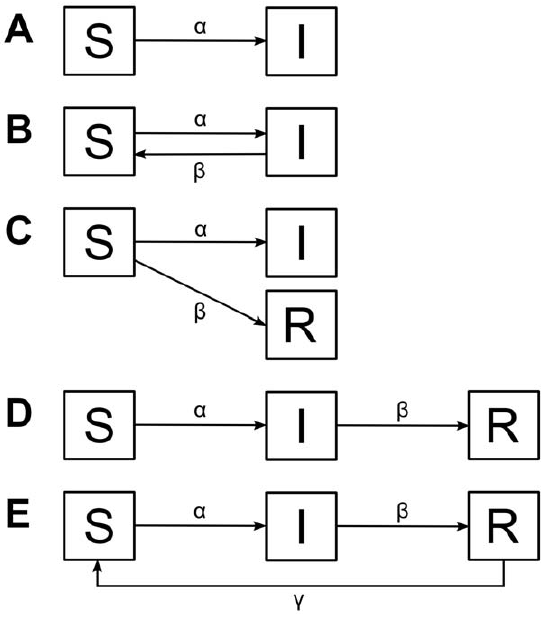
model: reversion to susceptible possible, C) SI/SR model: either infection or resistance, D) SIR model: some time after infection resistance occurs, E) SIRS model: it is possible to lose resistance and regain